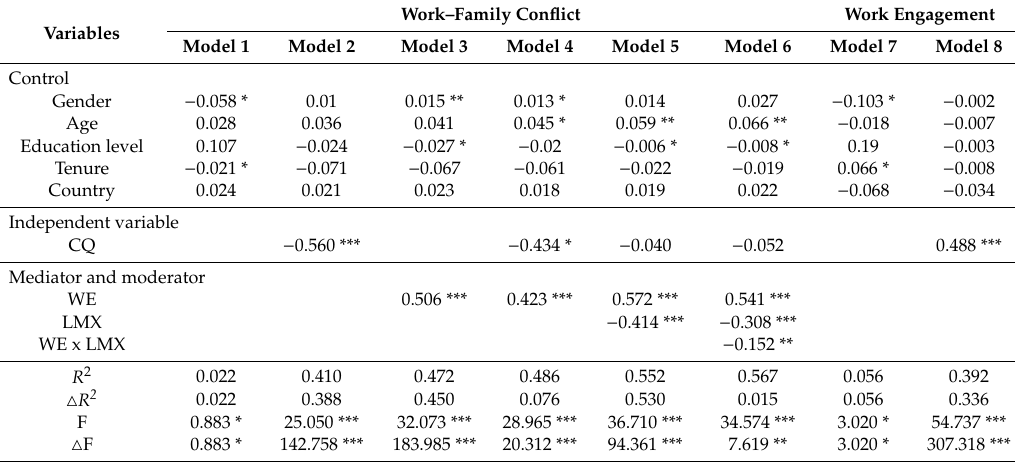
Table 3. Results of multiple regression